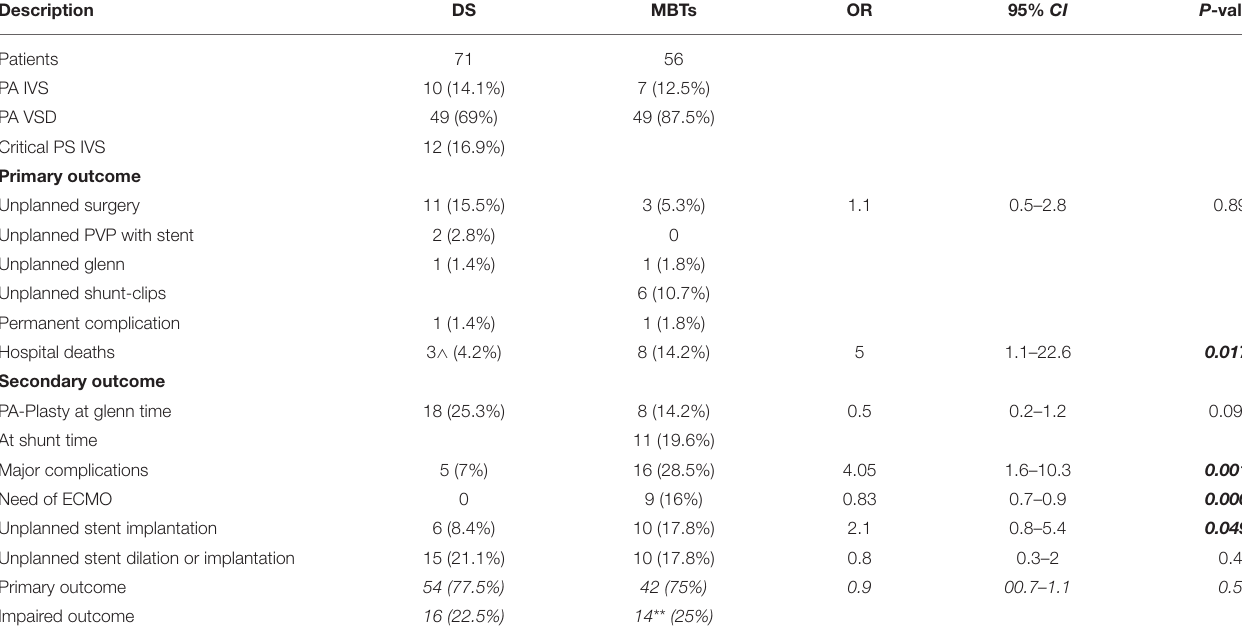
TABLE 1 | A summarized overview of diagnoses, complications, and outcomes in this cohort